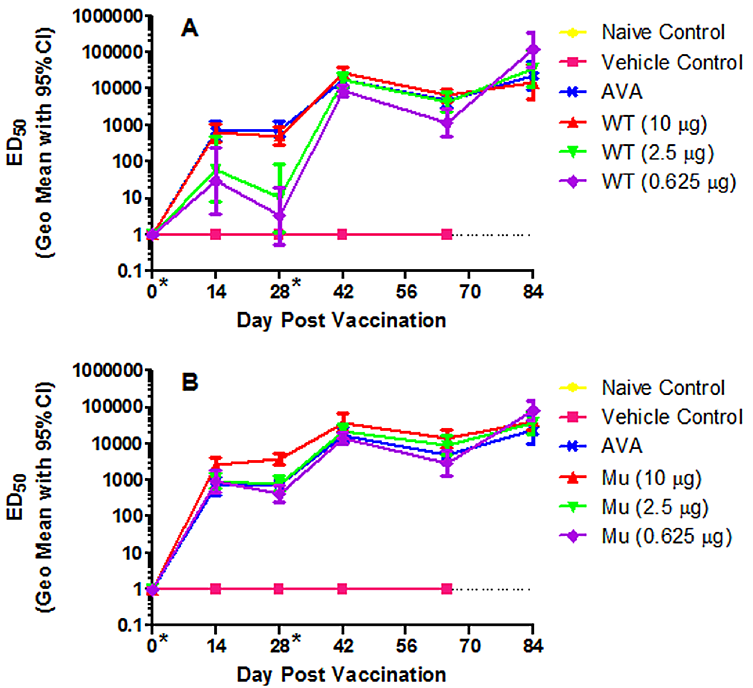
Fig 2. rPA antibody-specific Toxin Neutralization Assay (TNA) and ED50 values ( μ g/mL). (A) generated from vaccinated wild type and (B) mutant rPA (geometric mean with error bars representing the 95% confidence interval).